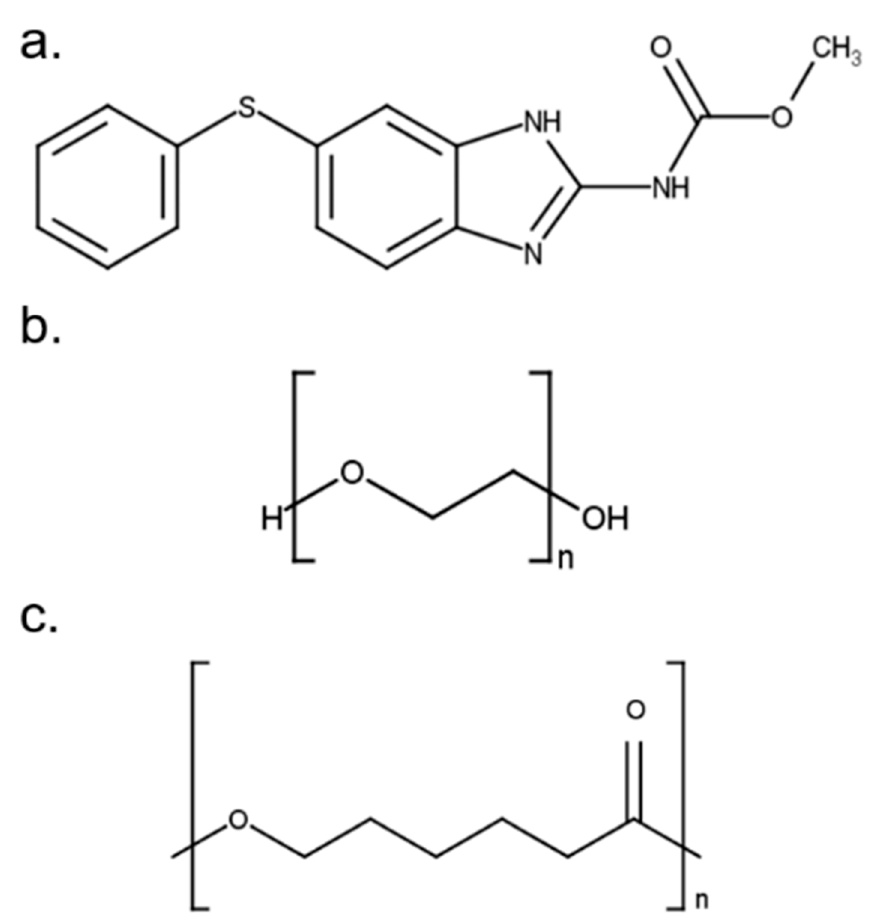
Figure 1. Chemical structures of ( a ) Fen, ( b ) PEO and ( c ) PCL designed using MarvinSketch